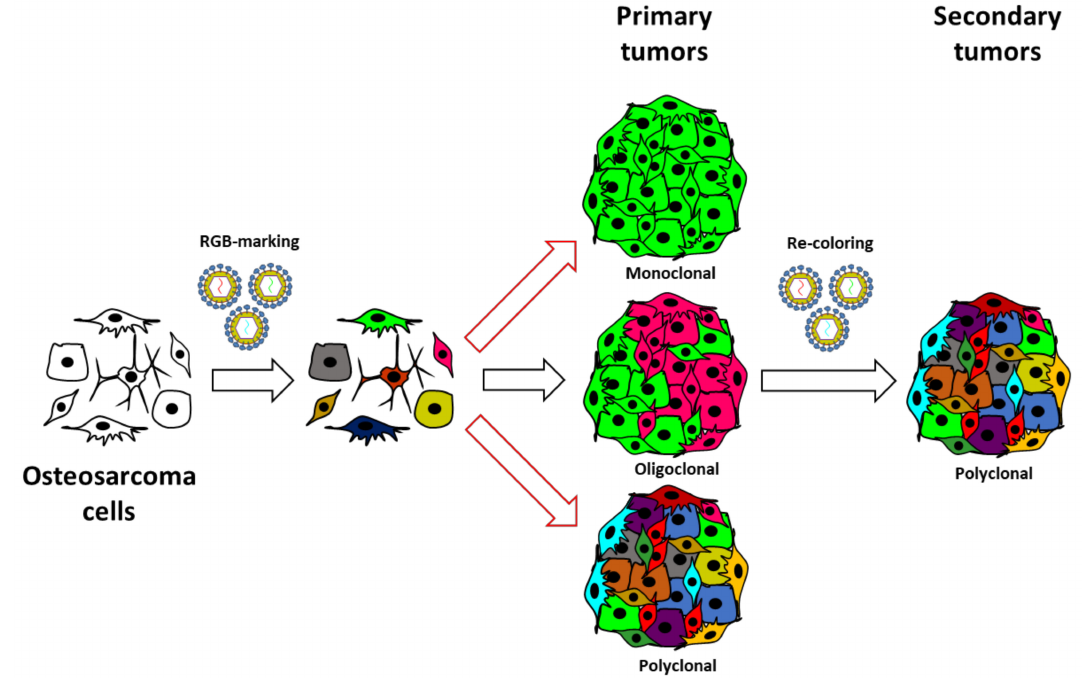
Figure 5. Revised model of OS growth. The schematic illustrates the experimental strategy and the clonal composition of induced OS through serial in vivo transplantation. Our study was based on the in vitro RGB marking of human, murine, and canine OS cells and in vivo evolution after their inoculation in immunodeficient mice. Our data indicate that selective events occur at primary transplantation, but when clonal populations overcome procedural selective forces, they follow a neutral growth model. This model agrees with the coexistence of different tumoral clones at primary transplantation and a sub-clonal heterogeneity at secondary